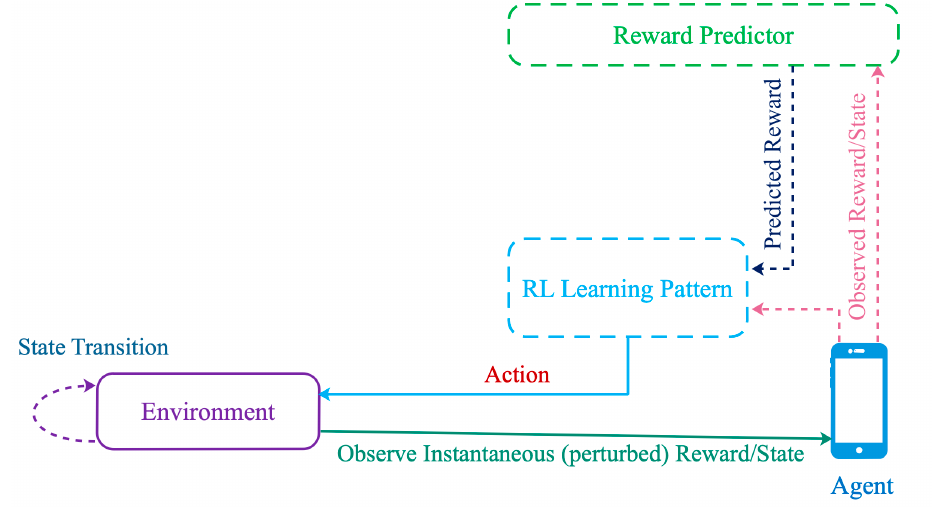
Figure 2. A decentralized reinforcement learning